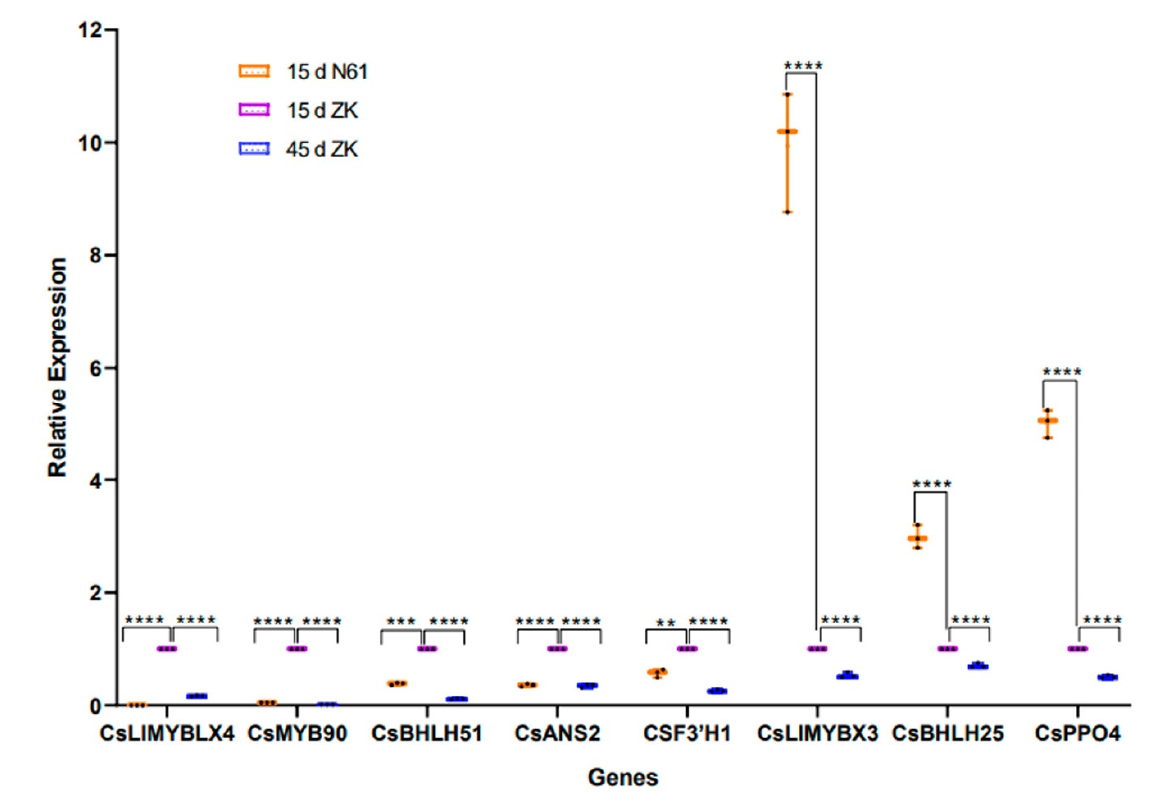
Figure 6. Expression of representative genes in Zikui (ZK) and N61 tea cultivars validated by quantitative real-time polymerase chain reaction (qRT-PCR). Presented as dot and whisker plots ( n = 3 independent biological samples; ** p ≤ 0.01, *** p ≤ 0.001, **** p ≤ 0.0001).